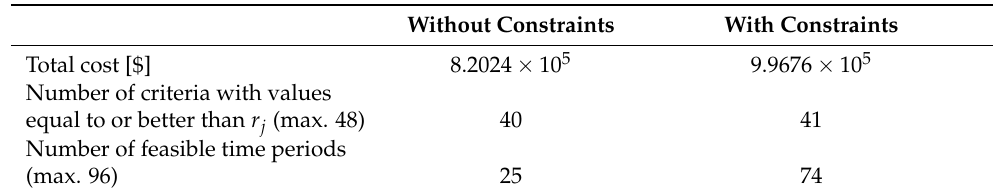
Table 6. Results of numerical tests—network constraints. Without Constraints With Constraints Total cost [$] 8.2024 × 10 5 9.9676 × 10 5 Number of criteria with values equal to or better than r j (max. 48) 40 41 Number of feasible time periods (max. 96) 25